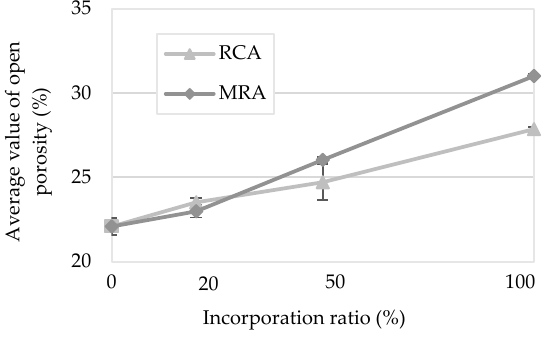
Figure 12. Open porosity of the mortars.